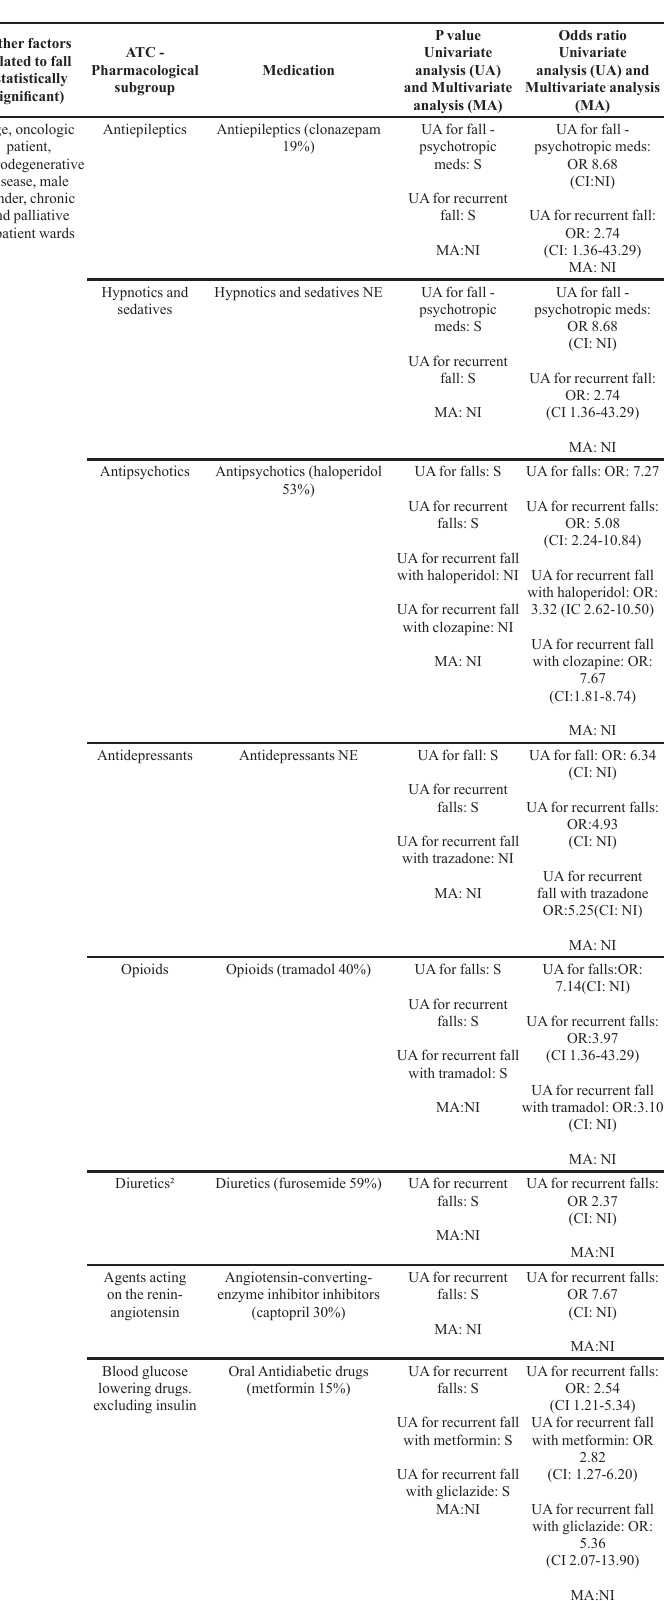
TABLE III - Eligible studies data